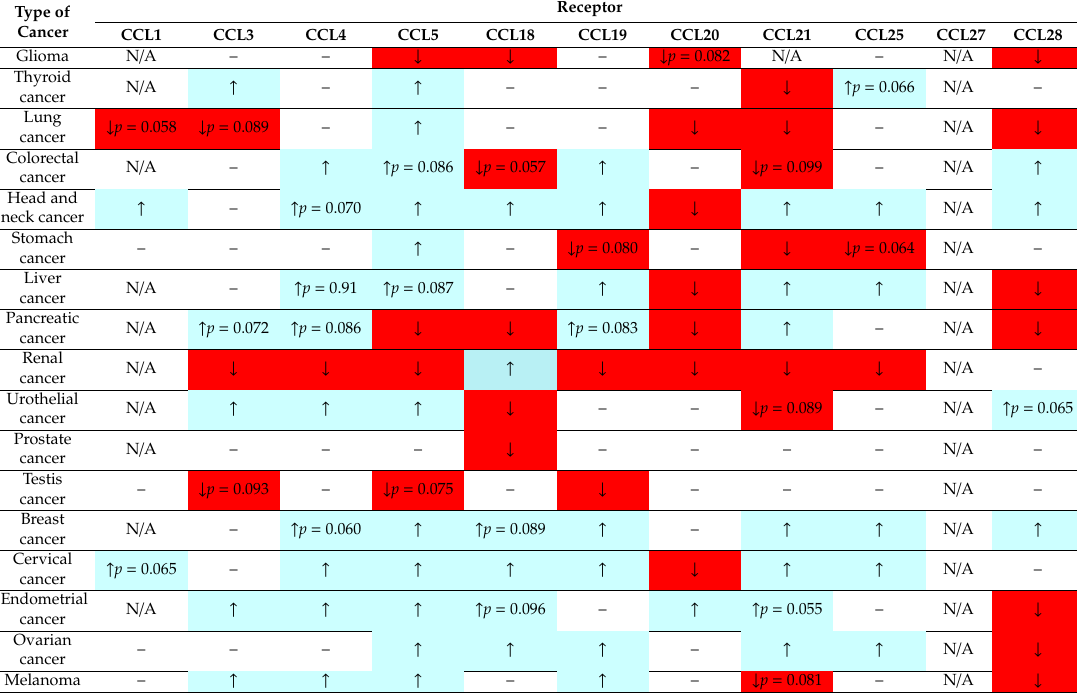
Table 1. Influence of increased expression of individual CC chemokines discussed in this review on the prognosis of patients with various cancers according to “The Human Protein Atlas”. (https: // www.proteinatlas.org / )